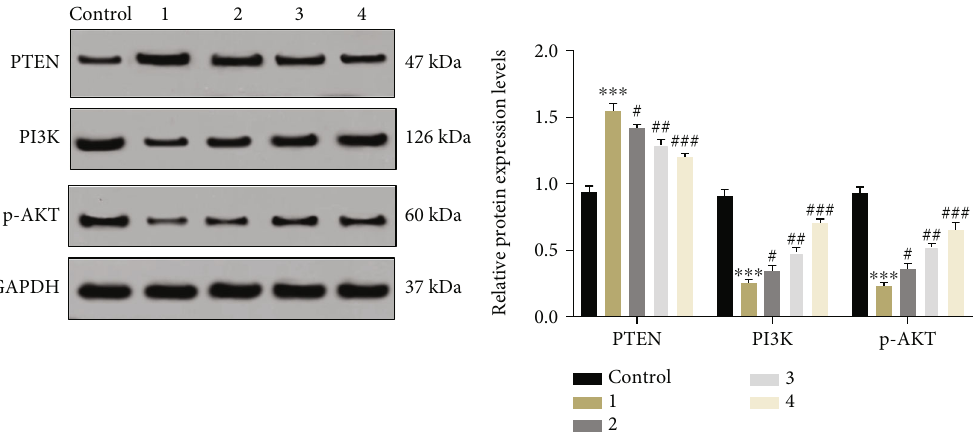
Figure 5: E ff ects of di ff erent concentrations of laminarin (0.5, 2.5, and 5 μ g/ml) on the protein expression levels of PTEN, PI3K, and p-AKT in PC12 cells induced by OGD/R. Note: 1: OGD/R group, 2: OGD+0.5 μ g/ml laminarin group, 3: OGD+2.5 μ g/ml laminarin group, and 4: OGD+5 μ g/m. Compared with the control group, ∗∗∗ P < 0 : 001 ; compared with the OGD/R group, # P < 0 : 05 , ## P < 0 : 01 , and ### P < 0 : 001